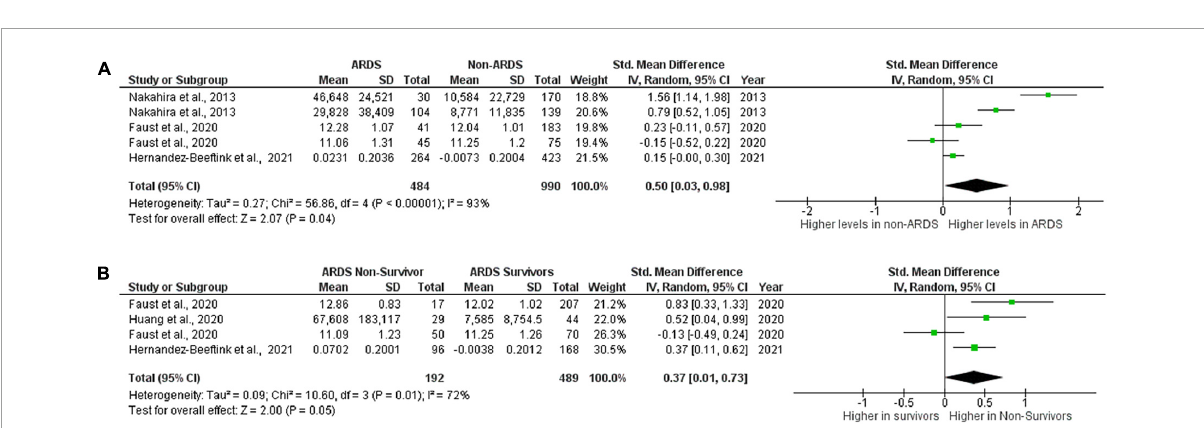
FIGURE3 Levels of circulating mtDNA. Forest plot meta-analysis of the levels of circulating mtDNA in ARDS patients and non-ARDS controls, P = 0.04 (A) and in ARDS survivors vs ARDS non- survivors P = 0.05 (B) . Data analysis generated on RevMan